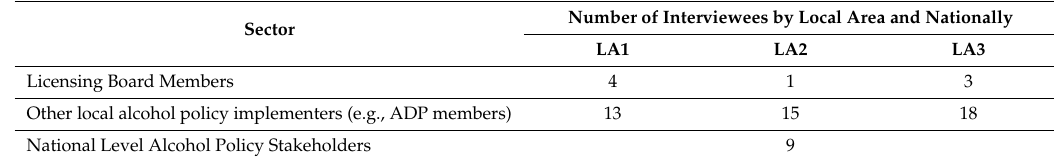
Table 3. Number of local- and national-level